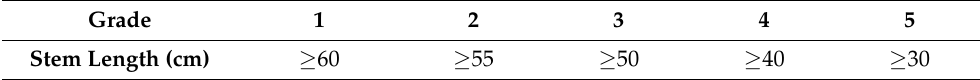
Table 2. Requirements of stem length grade for short-branch flowers.